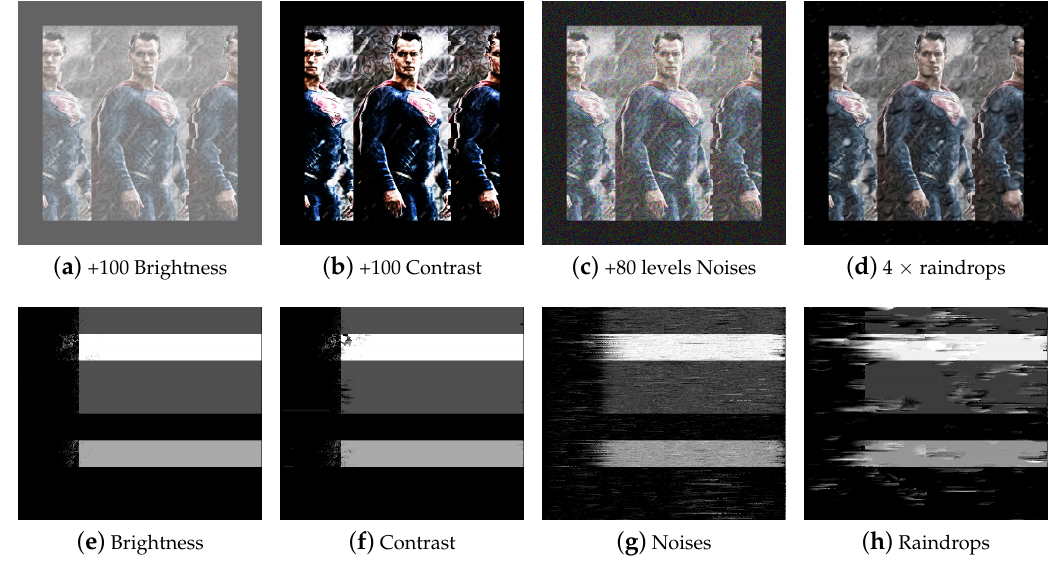
Figure 13. Four examples of PMBC tags after various effects added by IrfanView ( top row ) and their corresponding decoded disparity maps ( bottom row ).